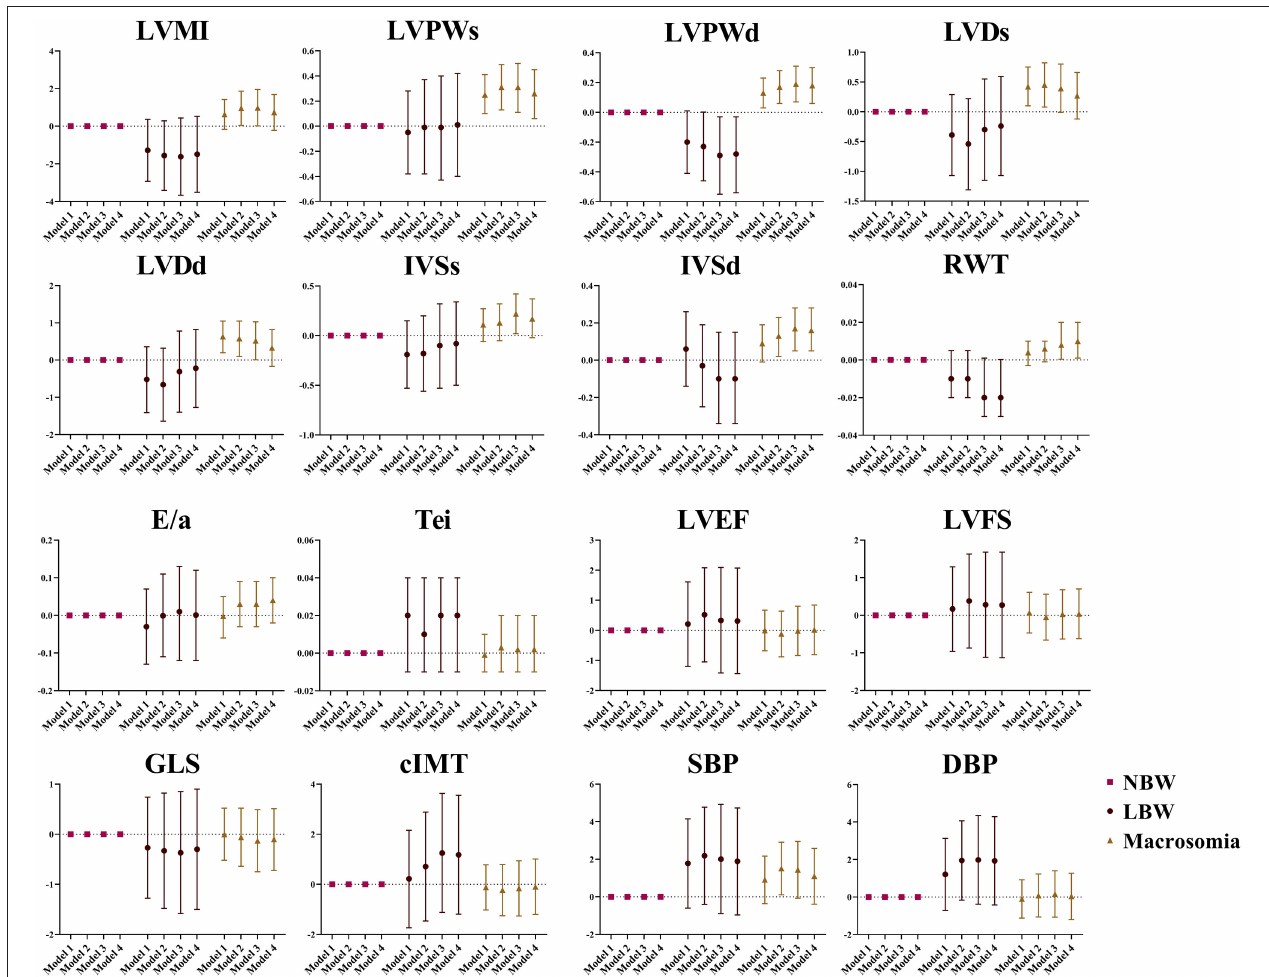
FIGURE 1 | The association between birthweight and cardiovascular parameters at the age of 4 years. Data was presented as mean difference with error bars displaying 95% confidence intervals for multivariable linear regression compared to participants with normal birthweight. Model 1: crude model; Model 2: adjusted for maternal factors including maternal age, ethnicity, educational level, alcohol intake (yes/no) and smoking status (yes/no) during pregnancy, gestational diabetes mellitus (yes/no), and hypertensive disorder during pregnancy (yes/no); Model 3: further adjusted for gestational age; Model 4: further adjusted for current BMI.